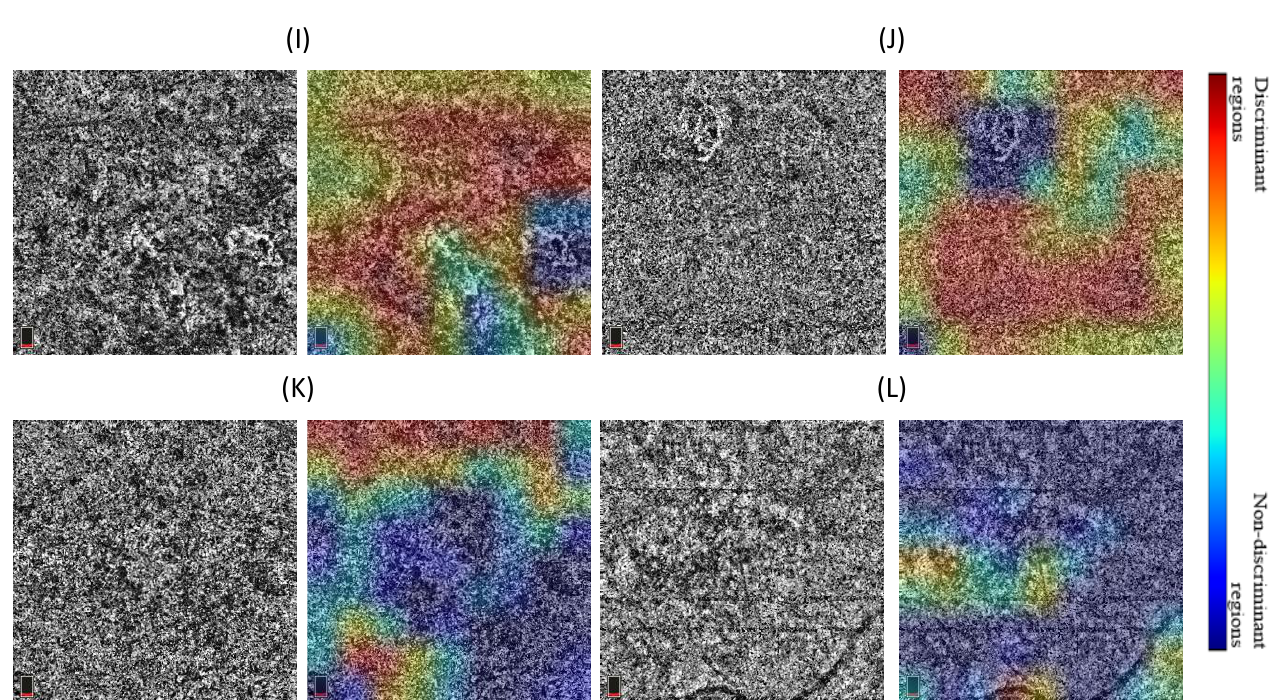
Figure 5. Grad-CAM visualizations for incorrect predictions by the proposed VGG19 modified model. To the right of each OCTA image, the corresponding Grad-CAM visualization of the CNN prediction. ( I , J ) advanced wet AMD (CNV) images, ( K ) intermediate AMD image and ( L ) No AMD (healthy CC) image.